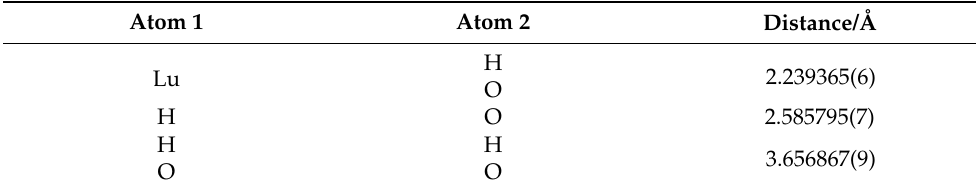
Table A2. The interatomic distances in cubic LuHO ( F 43 m ) up to 3 Å based on X-ray diffraction data at ambient temperature.